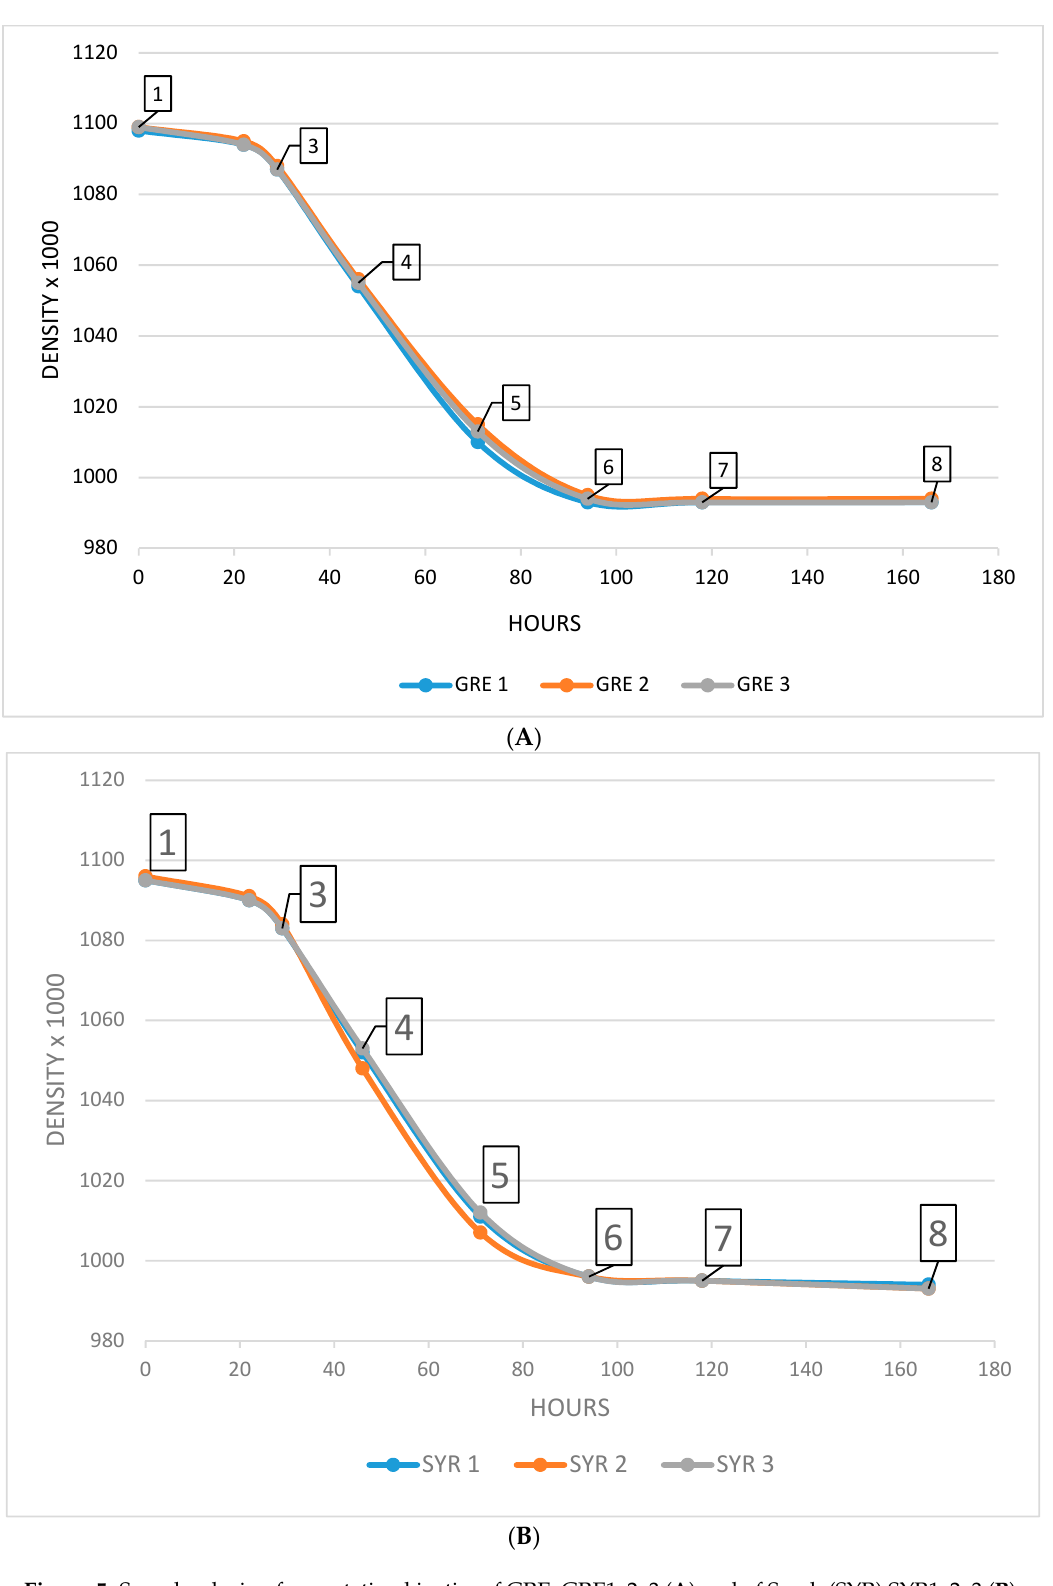
Figure 5. Samples during fermentation kinetics of GRE, GRE1, 2, 3 ( A ) and of Syrah (SYR) SYR1, 2, 3 ( B ).